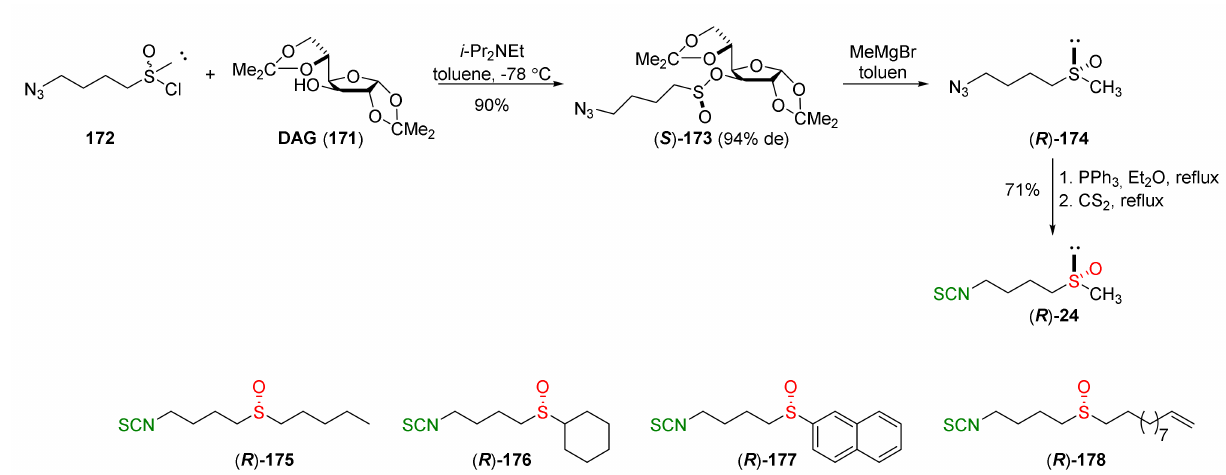
Figure 28. Synthesis of enantiopure ( R )-SFN (( R )- 24 ) and its enantiopure 175 – 178 analogues.